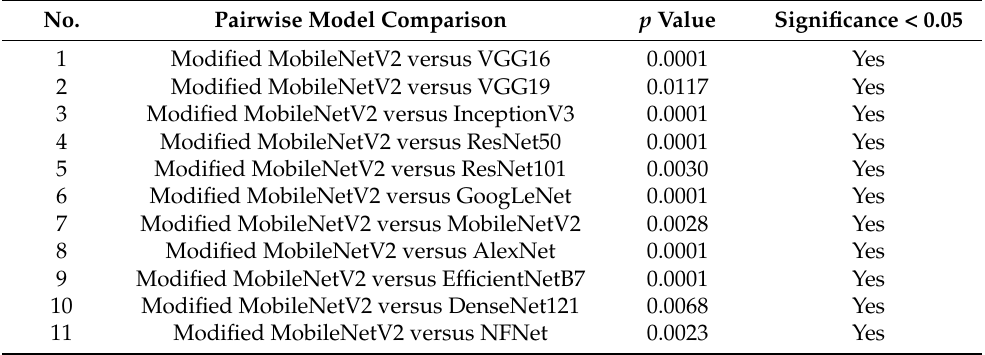
Table 10. Wilcoxon signed-rank test